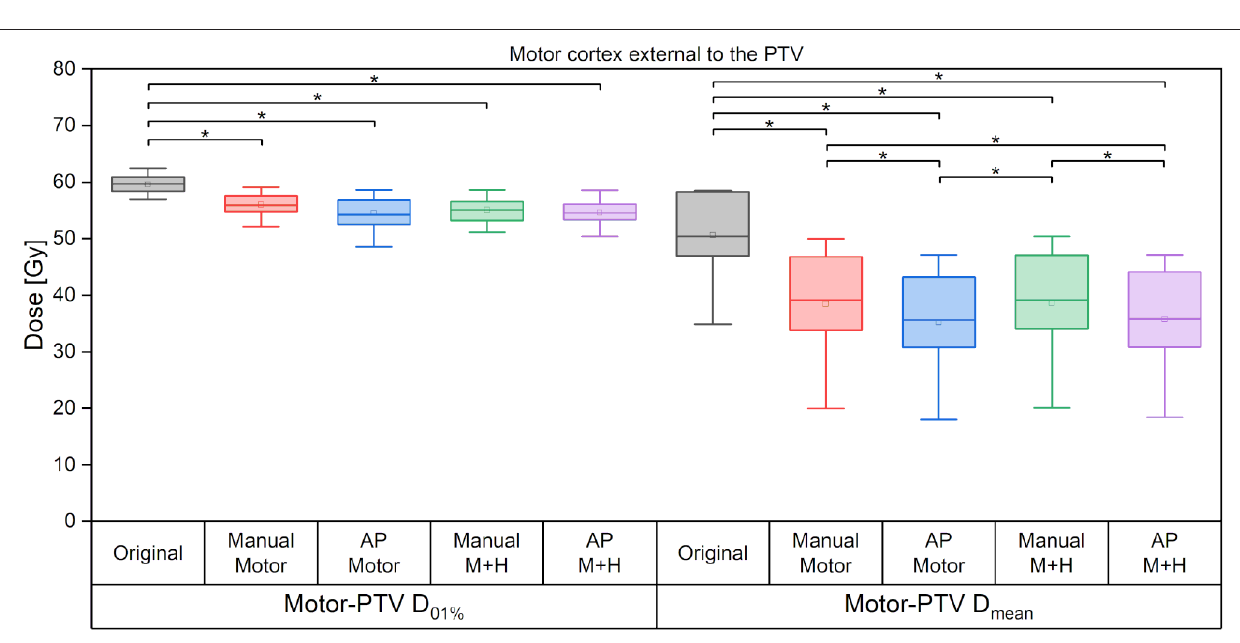
significant (“Original” 29.6 ± 18.3 Gy, “Manual Motor” 29.0 ± 17.3 Gy, “AP Motor” 25.4 ± 20.2 Gy, “Manual M + H”